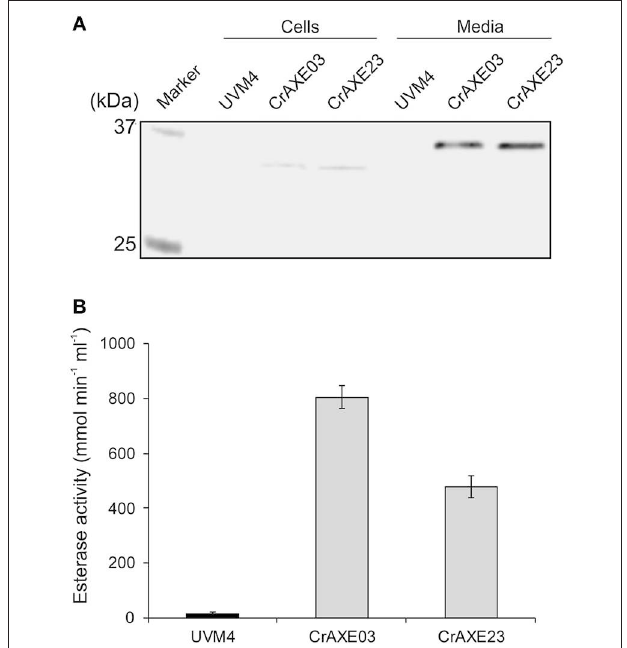
FIGURE 4 | Secretion of the CrAXE protein by the transgenic strains of C. reinhardtii . (A) Immunoblot analysis of cell lysates (Cells) and cell-free media fractions (Media). (B) Acetylesterase activity in cell-free media fractions. The UVM strain and the transgenic strains CrAXE03 and CrAXE23 were grown for 4 days in TAP media under the standard growth conditions. Two milliliters of each culture were centrifuged and the cell pellet and the media fraction were recovered. For immunoblotting, the cell pellet was resuspended in 200 µ L of water. Proteins in the media fraction were precipitated by cold acetone and resuspended in 200 µ L of water. The equal volume of each material was loaded on a SDS-PAGE gel and immunoblotting was performed using a monoclonal anti-strep antibody. Activity assays were performed directly for the media fraction using 4-nitrophenyl acetate.